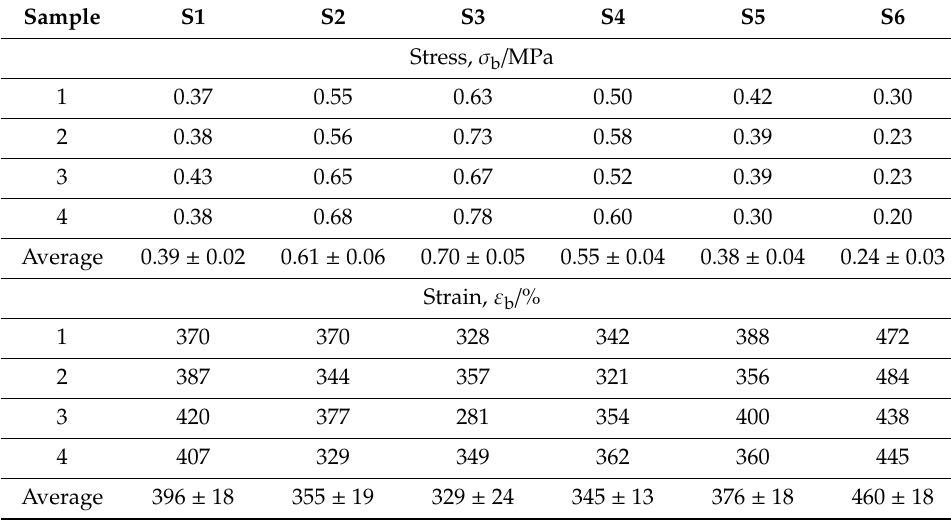
Table 3. Mechanical properties of PTPB elastomers.